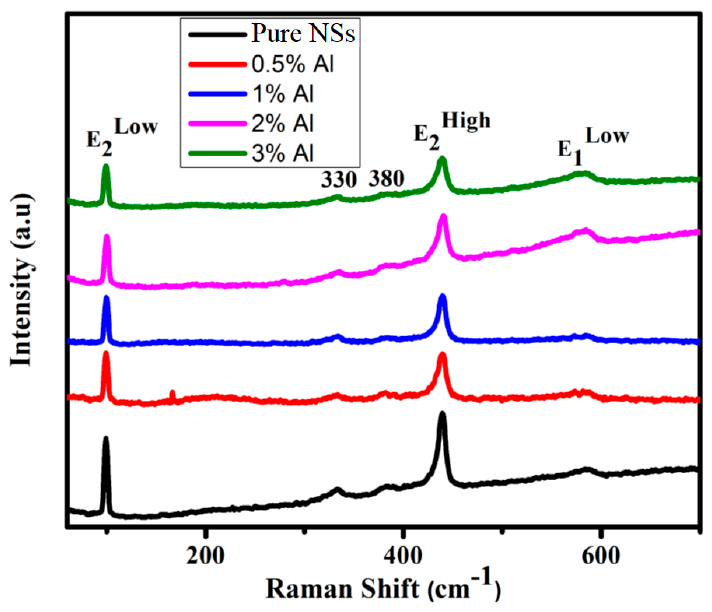
Figure 6. Raman spectra of pure ZnO and Al-doped ZnO NSs.